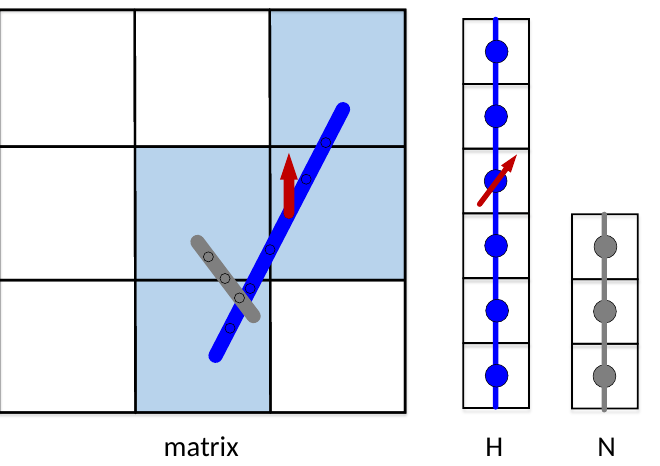
matrix Figure 9. Nodes in an EDFM for the matrix, a hydraulic fracture, and a natural fracture.